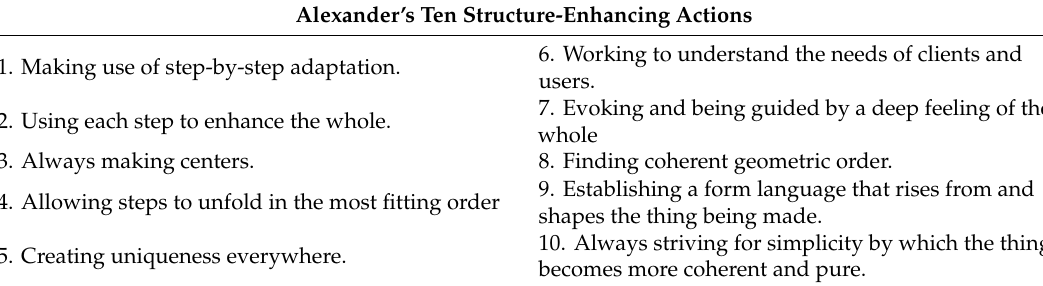
Table 2. Alexander’s 10 structure-enhancing actions [4] (p.